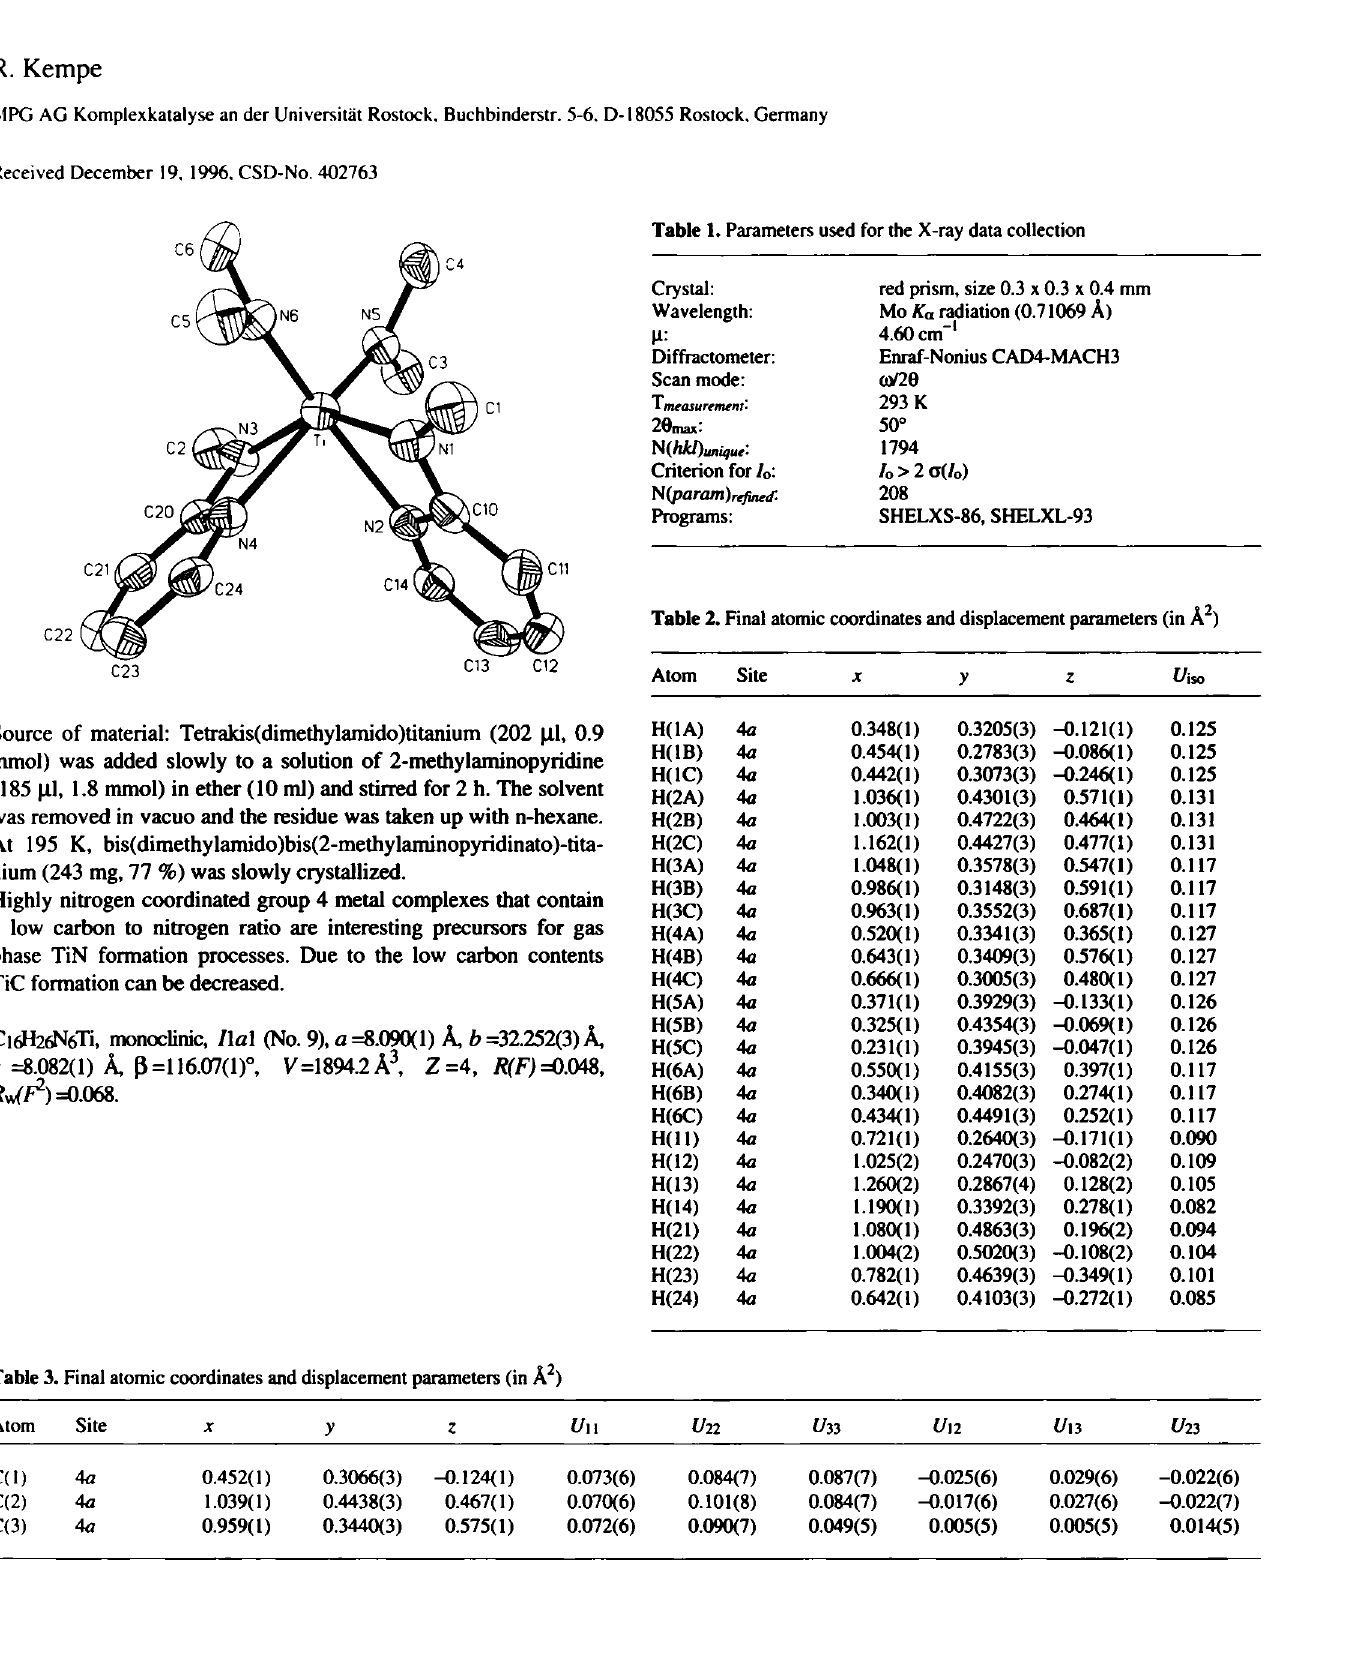
Table 3. Final atomic coordinates and displacement parameters (in Â 2